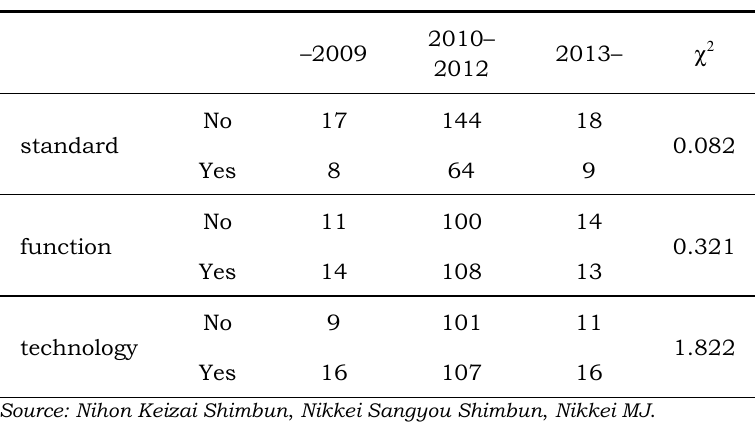
Table 1. Percentage of articles including “technological standard” or “function” or “technology"